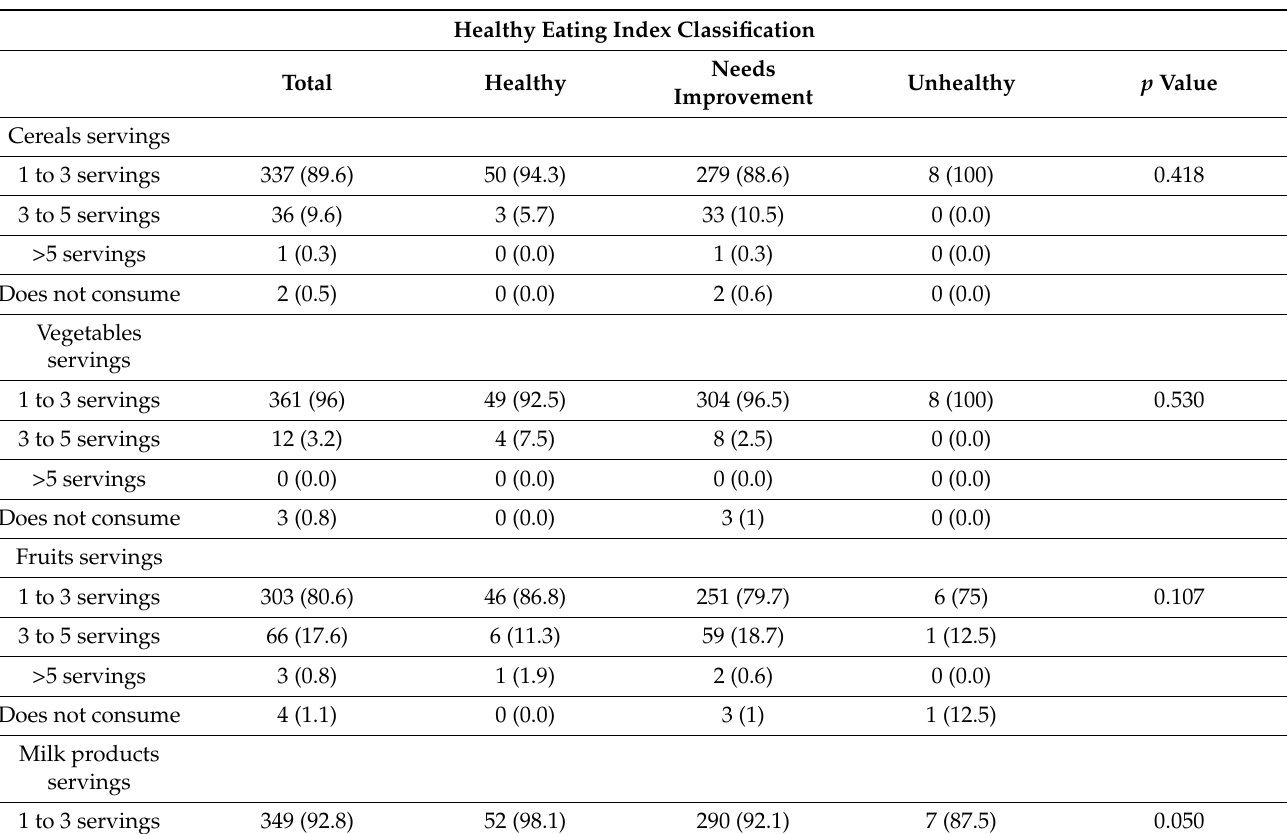
Table 4. Comparisons of food portion consumption between healthy eating index